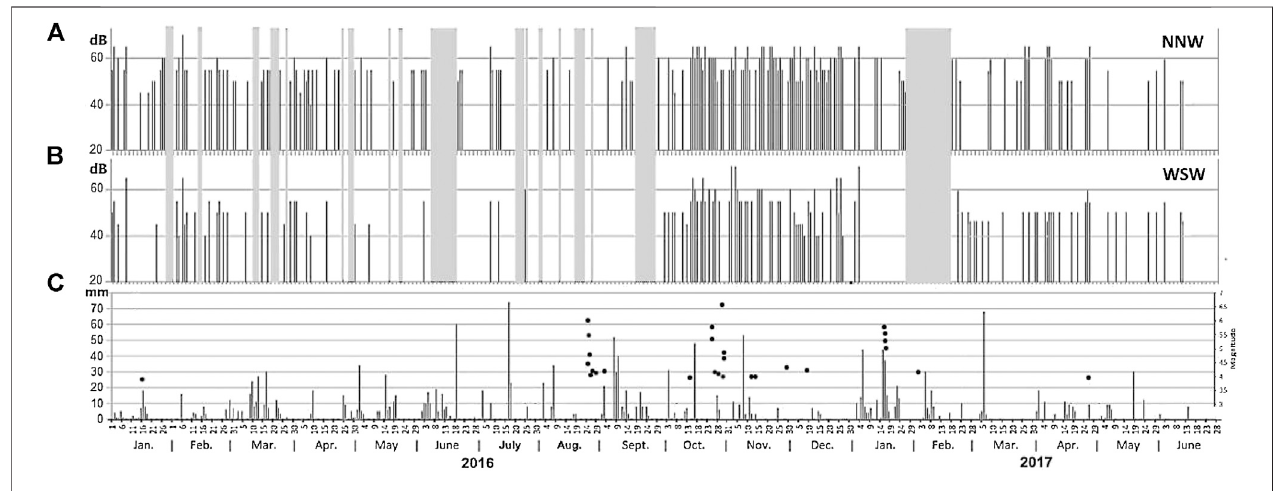
FIGURE5| ThedistributionofWSWelectricoscillations (A) andthedistributionofNNWelectricoscillations (B) areindicatedbyblackverticallines.Rainisindicated by vertical lines in (C) , together with strong seismic events, indicated by black circles. Periods of lost data are indicated by gray shadows for both (A,B) .